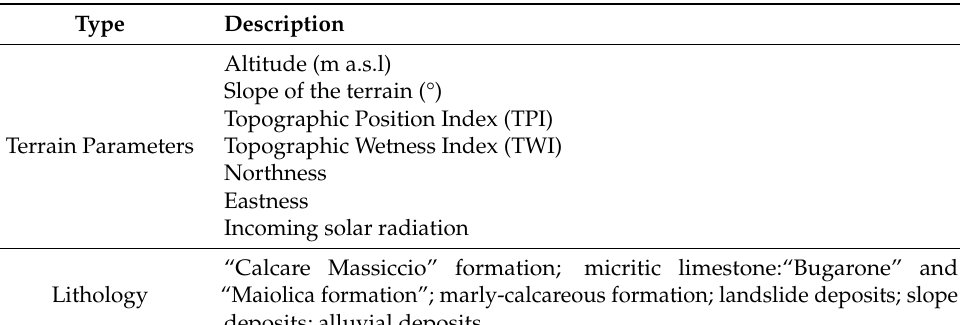
Table 2. Lithology and terrain parameters used as predictors in this work, derived from a Digital Elevation Model using the System for Automated Geoscientific Analyses (SAGA) GIS software.